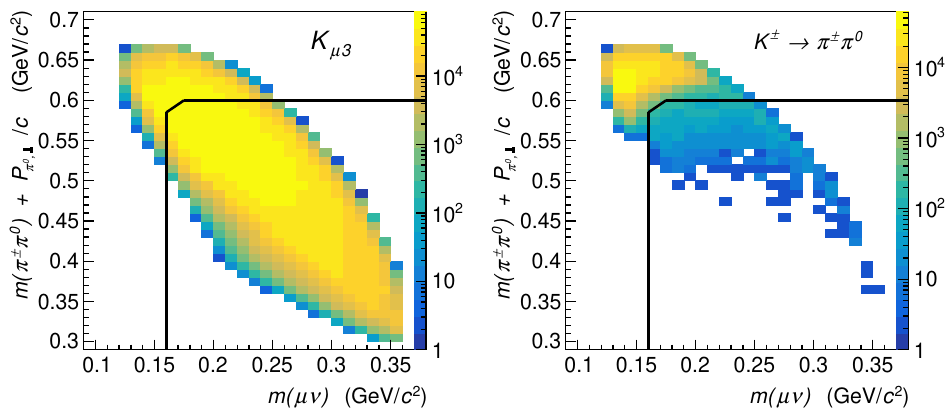
Figure 5 . Distributions of the kinematic variables used for K (cid:6) ! (cid:25) (cid:6) (cid:25) 0 background suppression for MC simulated signal K (cid:6) (left) and background K (cid:6) ! (cid:25) (cid:6) (cid:25) 0 (right) samples. The selection (cid:22) 3 criteria are indicated by solid lines.